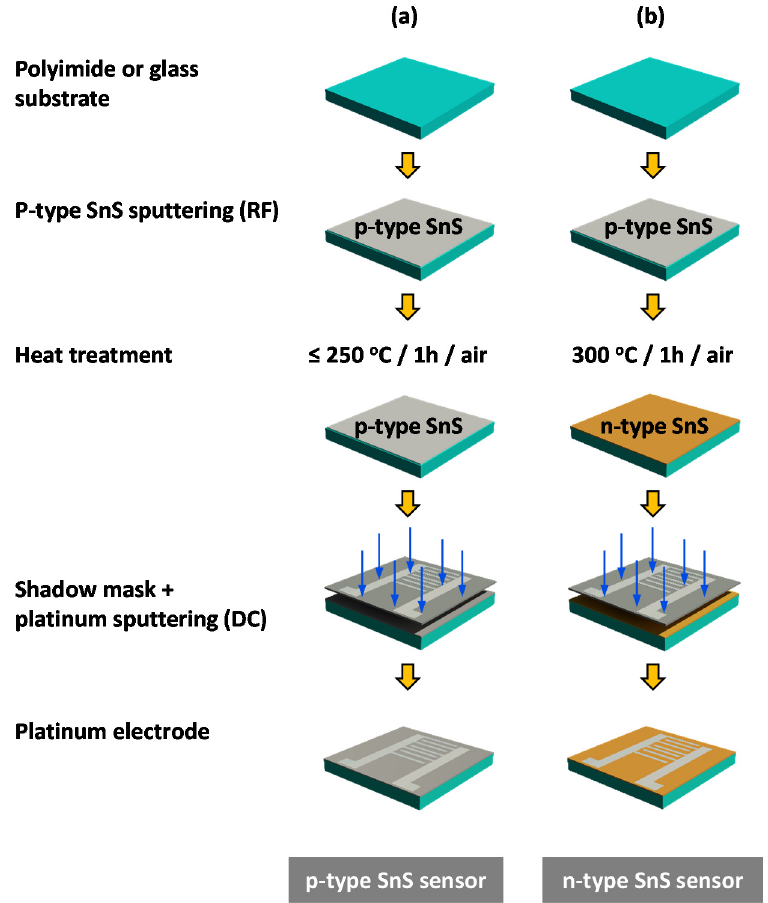
Figure 1. Illustration of the fabrication of tin sulfide (SnS) thin film sensors by sputtering: ( a ) a p-type SnS sensor, and ( b ) an n-type SnS sensor.